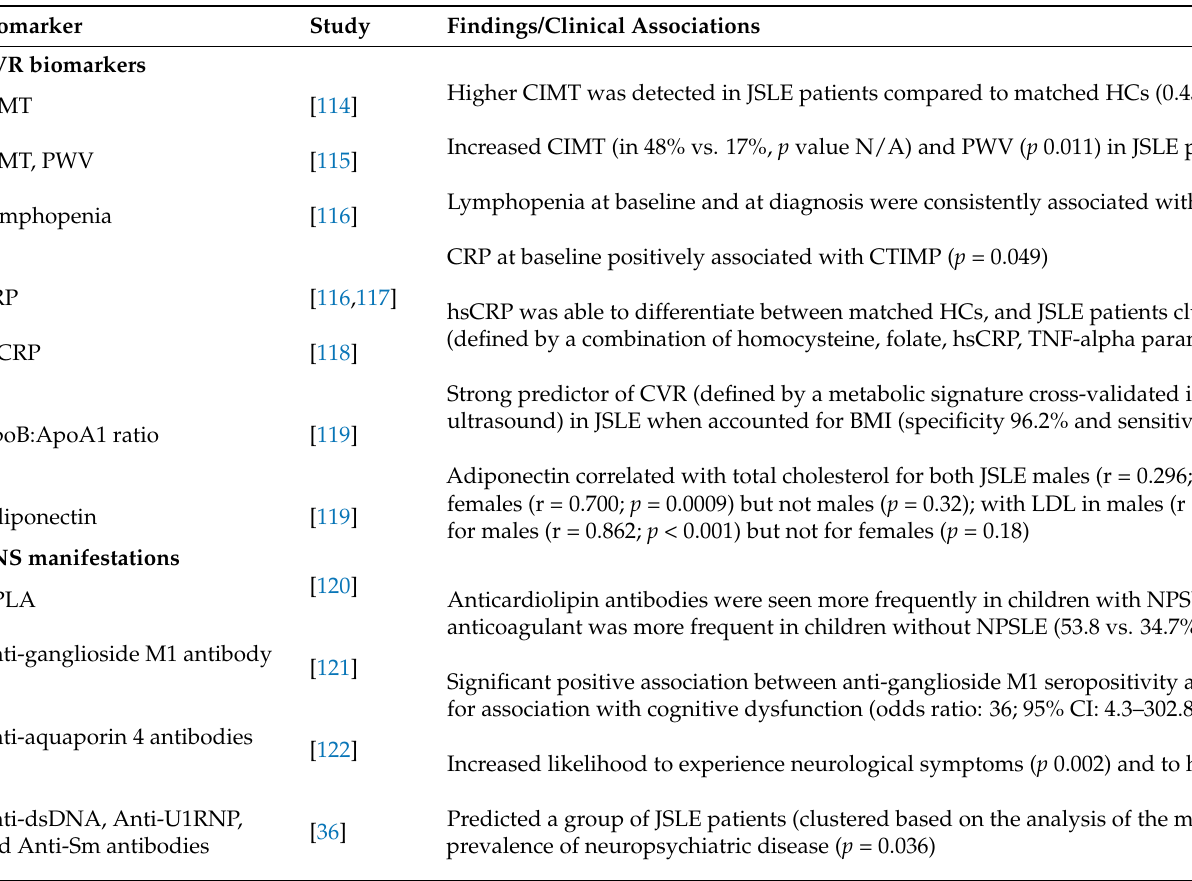
Table 5. Biomarkers for other organ involvement.